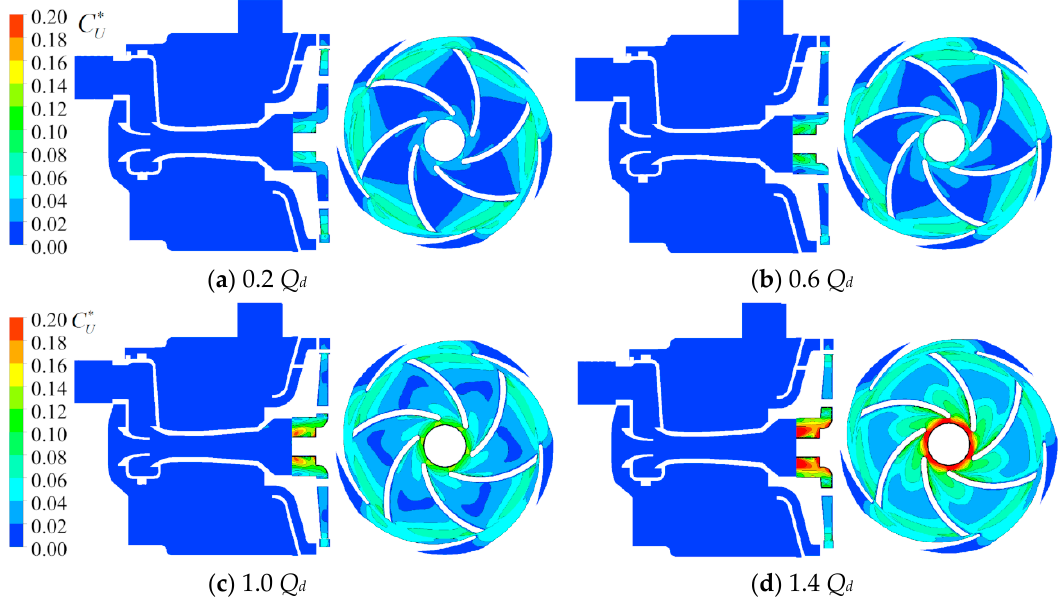
Figure 9. Fluctuation intensity distribution contours of velocity on two planes under four conditions.